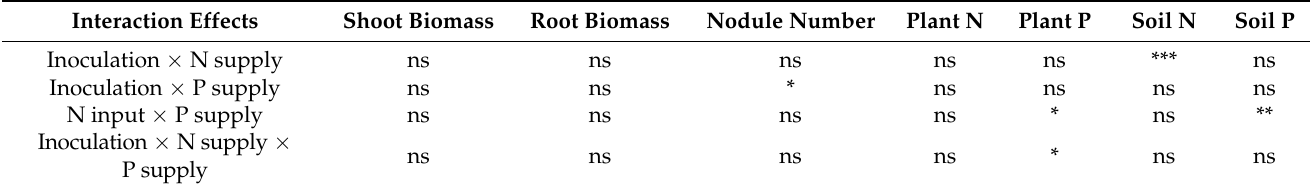
Table 3. Interaction effects of inoculation, N and P supplies on shoot and root biomass, nodule number and concentrations of plant and soil nutrients. Significance denoted by * p < 0.05, ** p < 0.01, *** p < 0.001, ns, not significant.